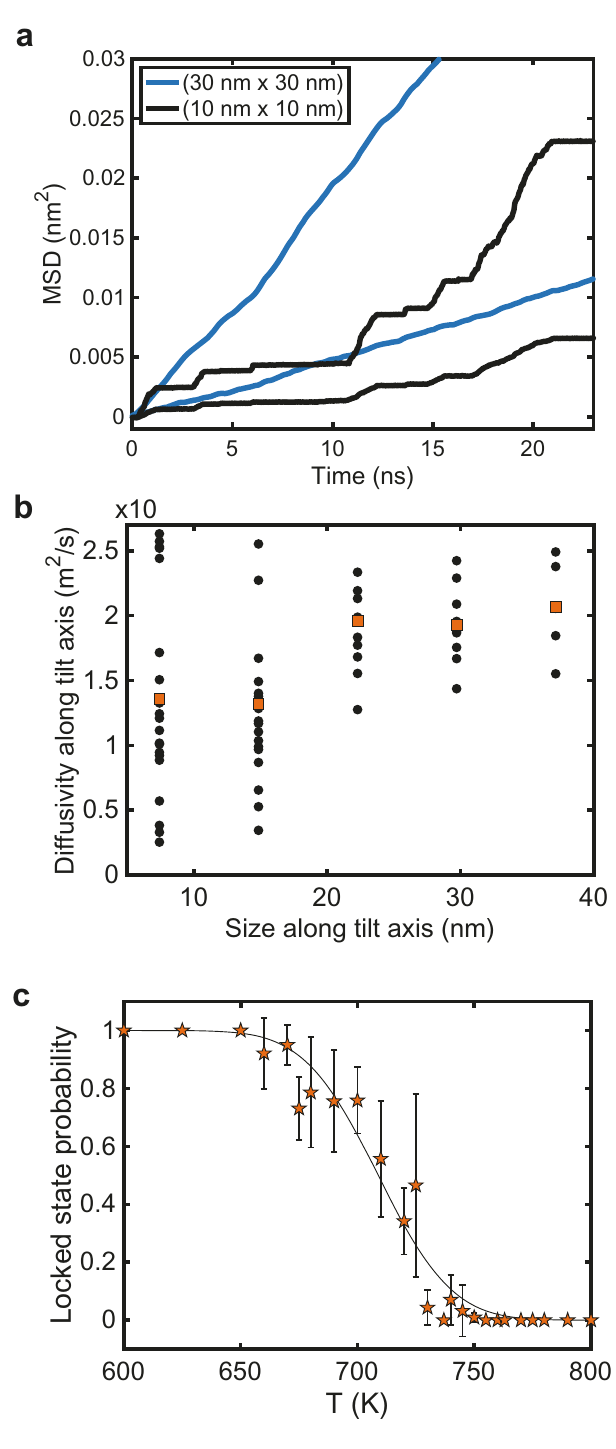
Fig. 4 Finite size effects of diffusion and temperature dependence. a Atomic MSD versus time at the temperature of 700 K (0.75 T m ) for